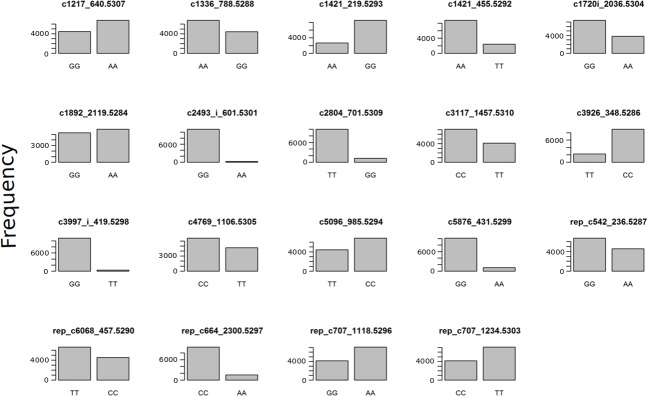
The global allele frequencies of the 19 SNP loci used for genotyping.